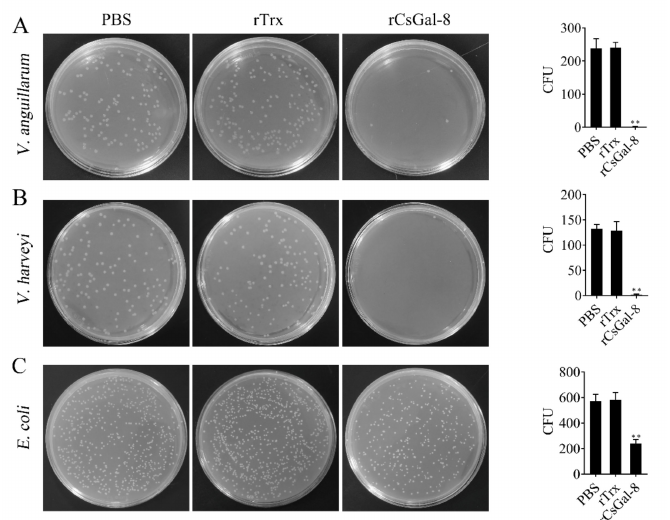
Figure 8. The bactericidal activity of rCsGal-8. V. anguillarum ( A ), V. harveyi ( B ) and E. coli ( C ) were incubated with 1 µ M rCsGal-8 or rTrx or PBS (control) for 1 h. The bacteria were plated on LB plates and incubated for 12 h. The number of colony-forming unit (CFU) was counted and shown on the right panels. Values are the means of three experimental replicates and shown as means ± S.D. ** p <